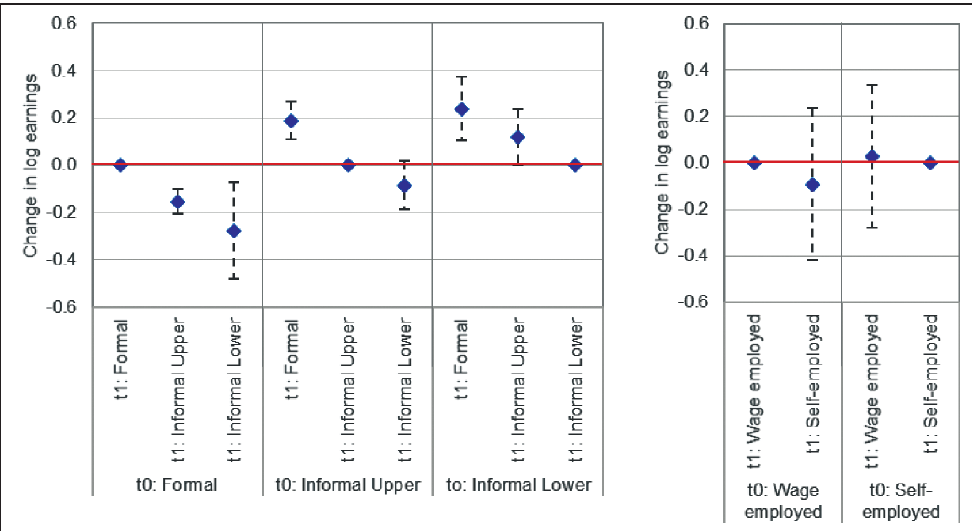
Figure C3 Coefficient estimate on change in log earnings, split-sample